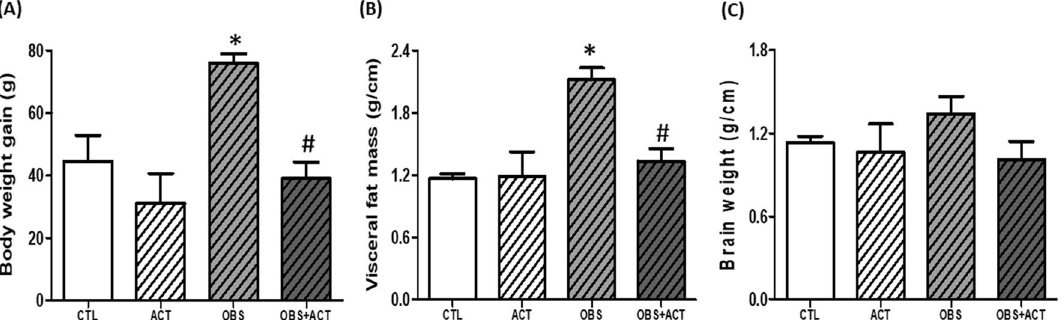
Figure 1. Effects of acetate on body weight gain ( A ), visceral fat mass ( B ) and brain weight ( C ) in high fat diet-induced obese Wistar rats. Body weight gain and visceral fat mass but not brain weight increased in obese rats, which were attenuated following the administration of acetate. Data are expressed as mean ± SD. n = 6 and analyzed by one-way ANOVA followed by Bonferroni post hoc test. (* p < 0.05 vs. CTL; # p < 0.05 vs. OBS). CTL Control; OBS Obesity, ACT